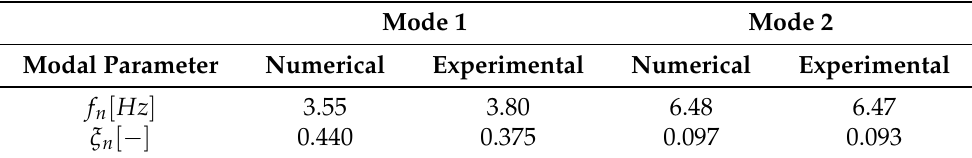
Figure 13. Test case 2: experimental impulse response. Table 5. Test case 2: closed-loop numerical and experimental modal parameters.